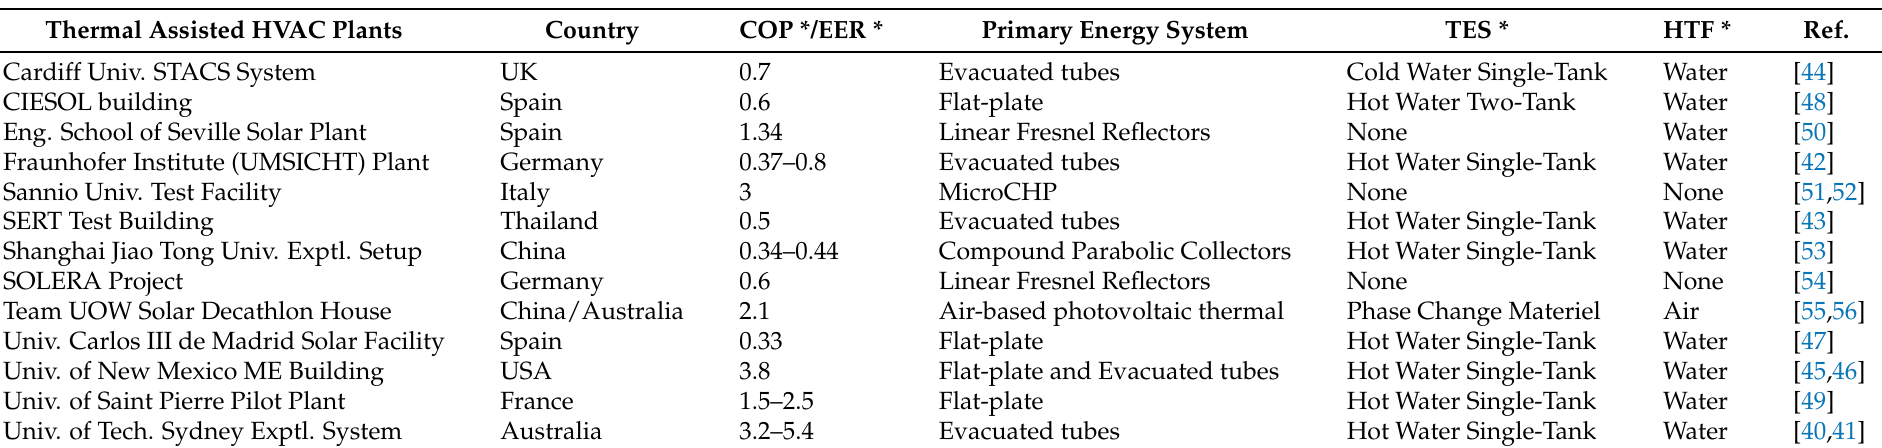
Table 1. Non-MicroCSP identified Thermal-assisted HVAC